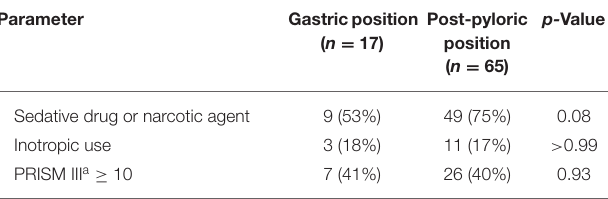
TABLE 4 | Factors influencing the success rate of post-pyloric position of feeding tube.